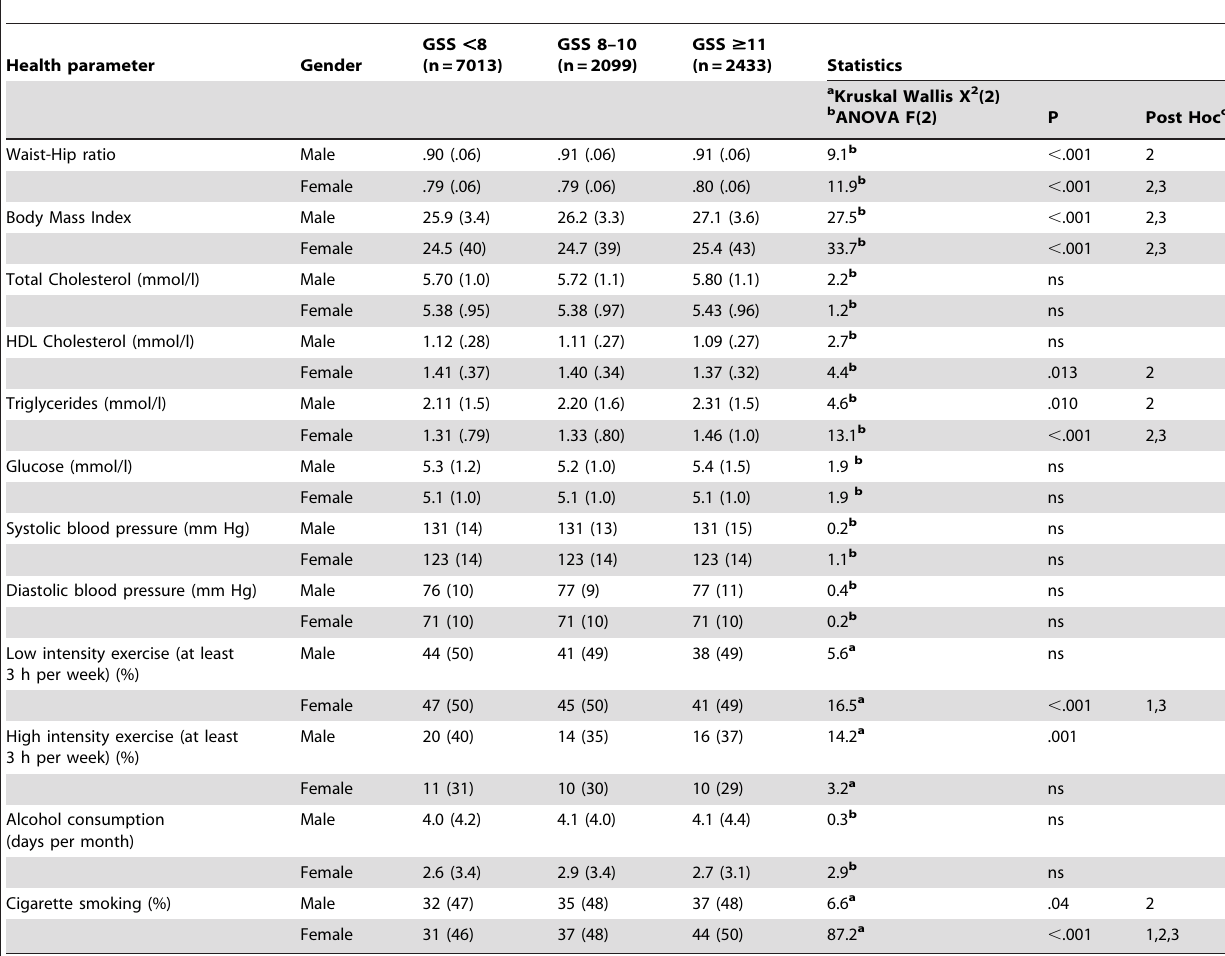
Table 1. Objective health measurements and health behaviours in different seasonality groups (n=11,545).